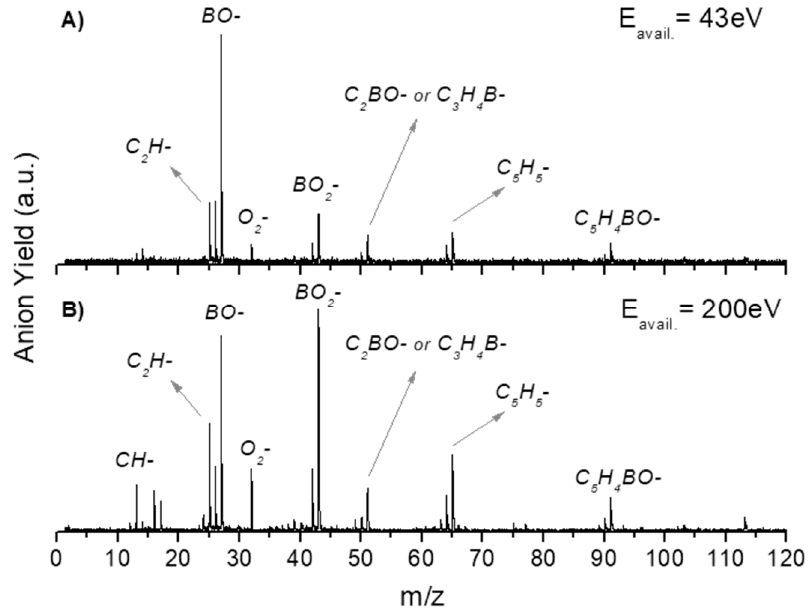
Figure 2. Time-of-flight negative ions mass spectra in neutral potassium collisions with phenylboronic acid at a 70 eV ( A ) and 300 eV ( B ) collision energy (43 eV and 200 eV available energy). The most intense fragments are assigned.